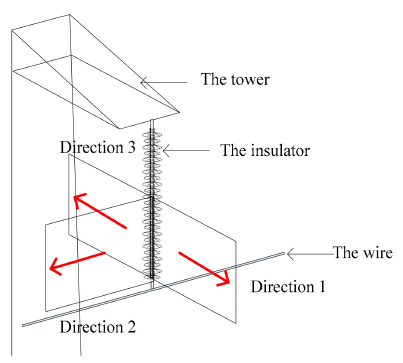
Figure 8. The schematic diagram of direction 1, 2, 3.